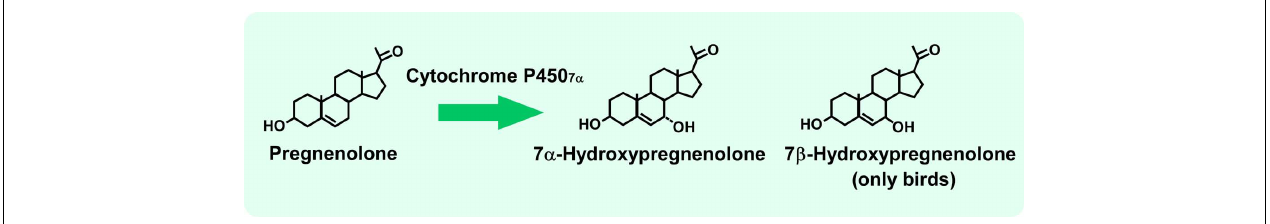
FIGURE 1 | 7 α -Hydroxypregnenolone synthesis by cytochrome P450 7 α in the brain of newts and quail. See the text for details.